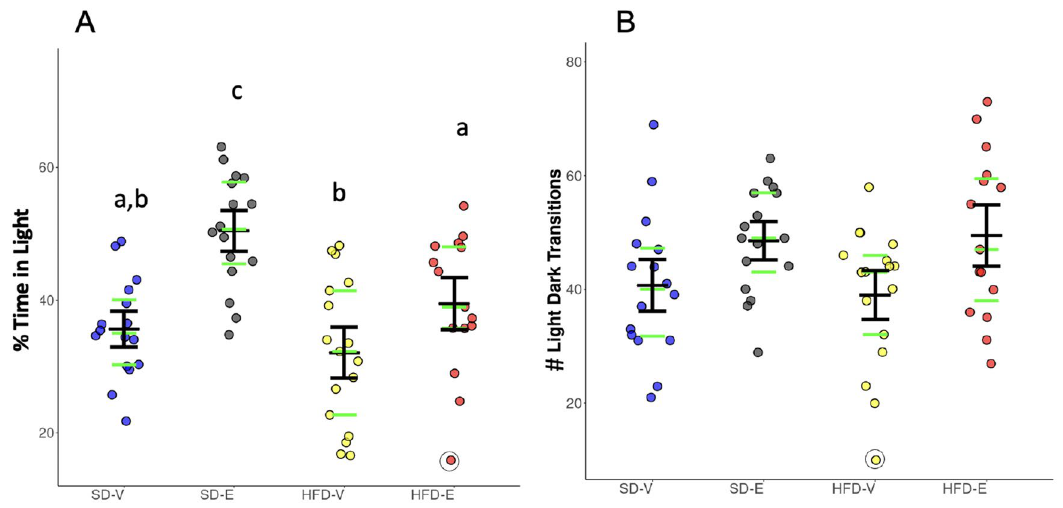
Figure 2. Estradiol reduces anxiety-like behavior in both SD and HFD-fed mice in Light–Dark test (n = 15–16/ group). ( A ) Percent (%) time spent in the light compartment. ( B ) The number of light/dark transitions. Black lines show mean (middle line) and 83% CI (whiskers). Green lines show median (middle line) and the 1st (lower line) and the 3rd quartile (upper line). Data points greater than 1.5 times the interquartile range are shown within open circles. Different letters denote differences across groups, P < 0.05, Tukey’s